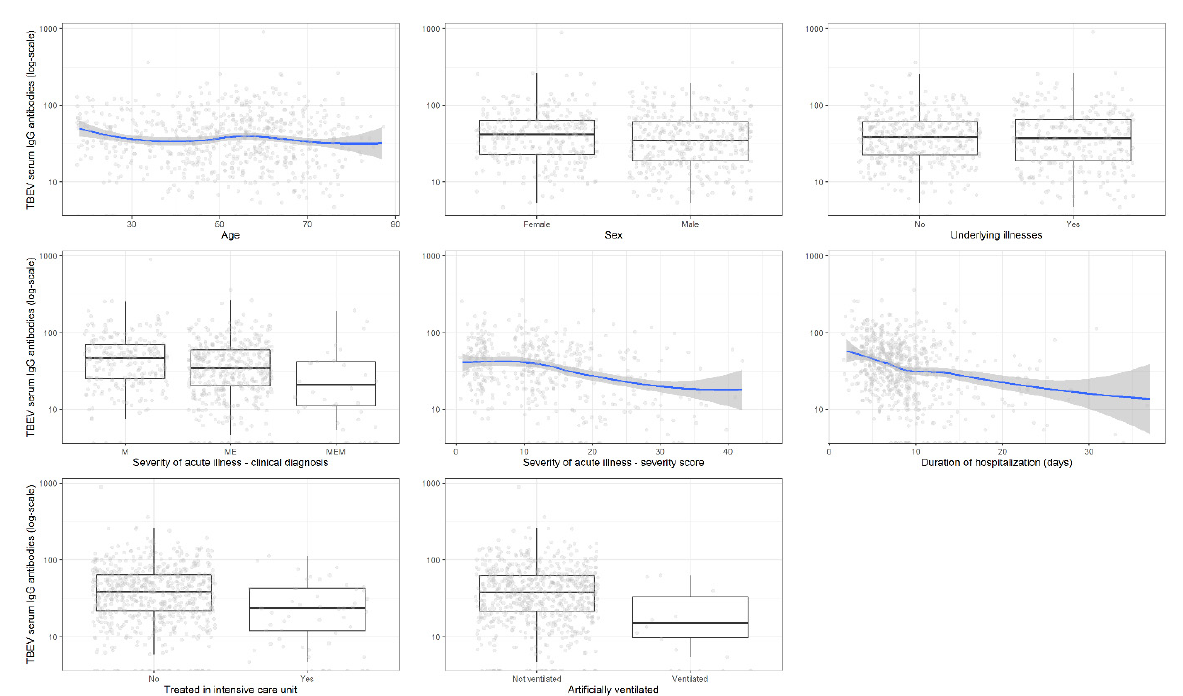
Figure 1. Association of tick ‐ borne encephalitis virus IgG antibody levels in serum (log ‐ scale) with basic demographic and clinical findings including disease severity. Legend: TBEV, tick ‐ borne encephalitis virus.